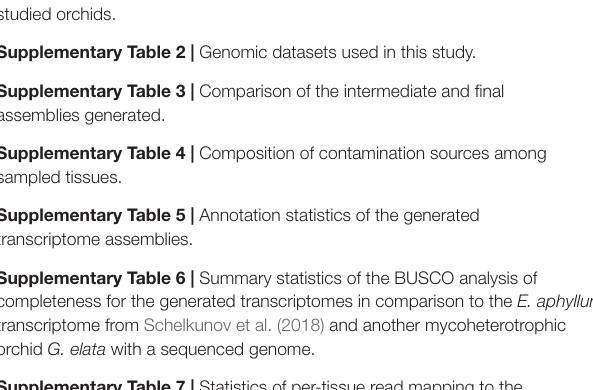
Supplementary Table 7 | Statistics of per-tissue read mapping to the intermediate and final